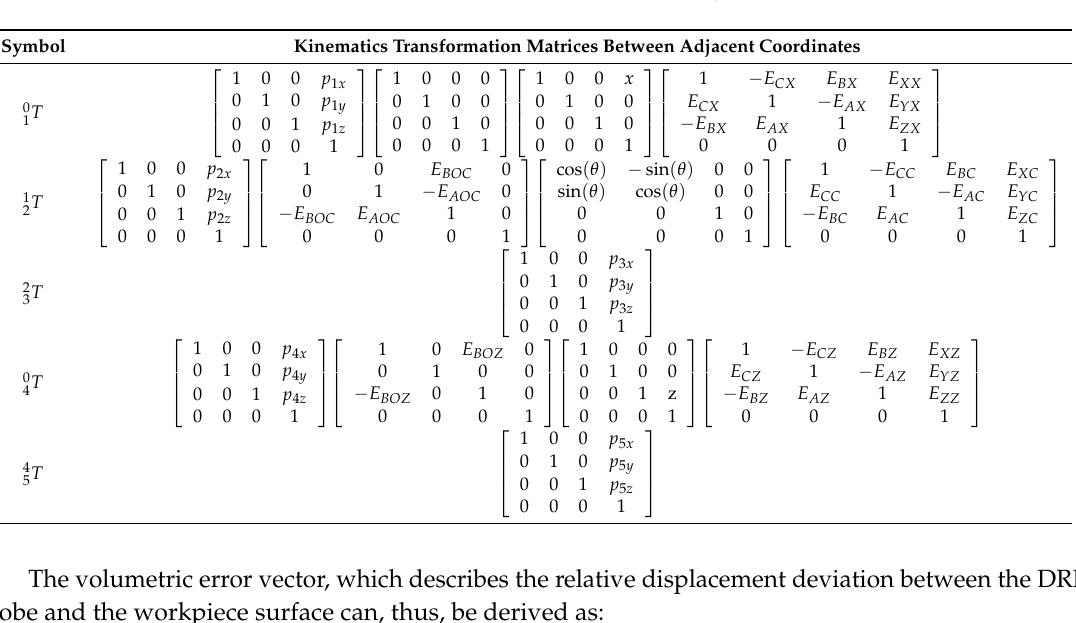
Figure 4. Configuration of the machine tool coordinate systems. Table 1. Kinematics transformation matrices between adjacent coordinates.